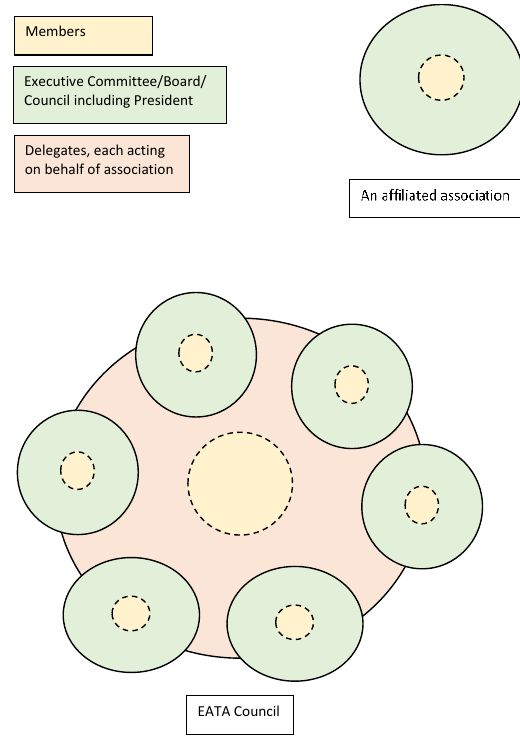
Members elect their own executive committee, or board, or council, depending on which term they use.